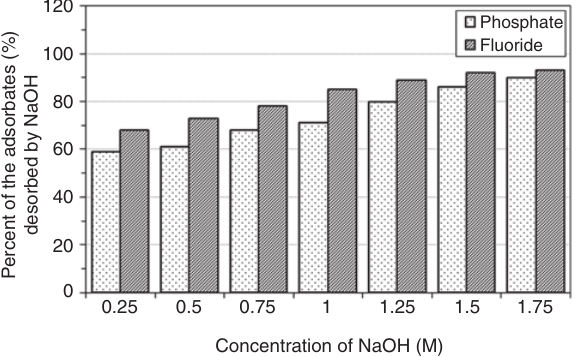
Figure 10: Influence of NaOH concentration for desorbing phos- phate and fluoride from